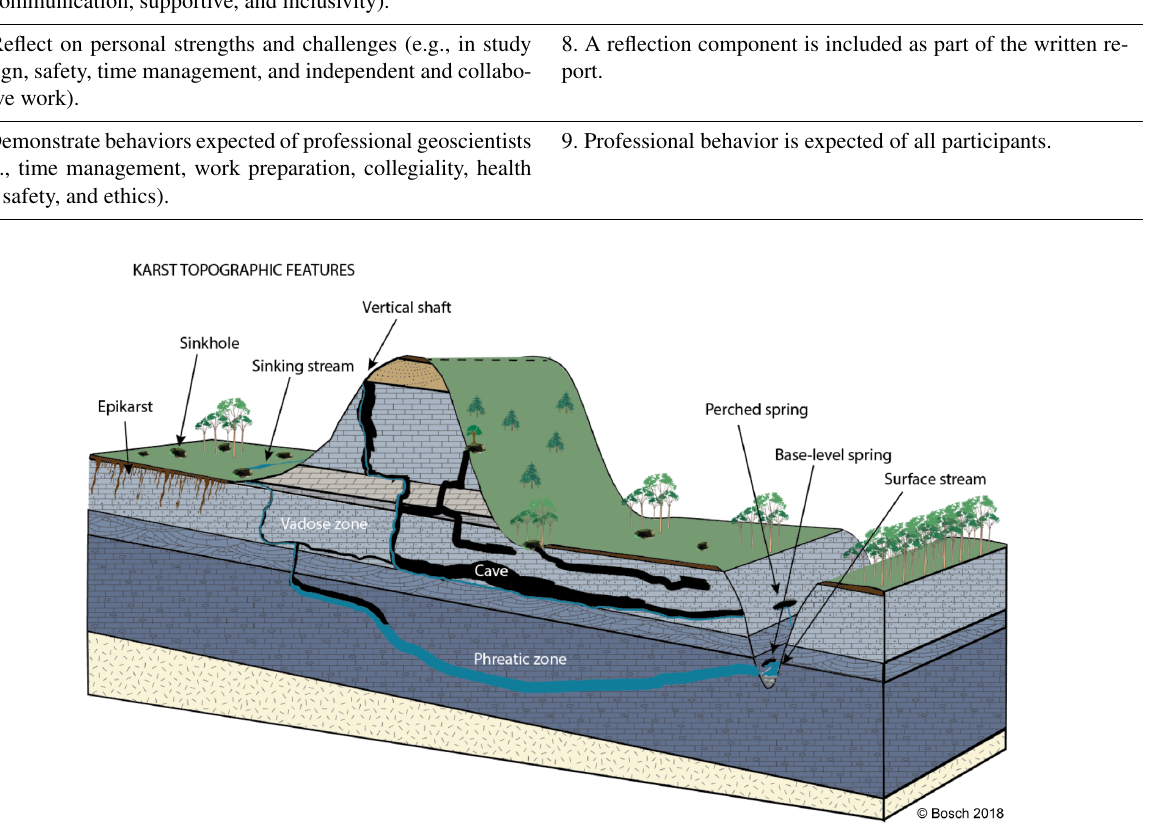
Figure 1. Block diagram of generalized karst